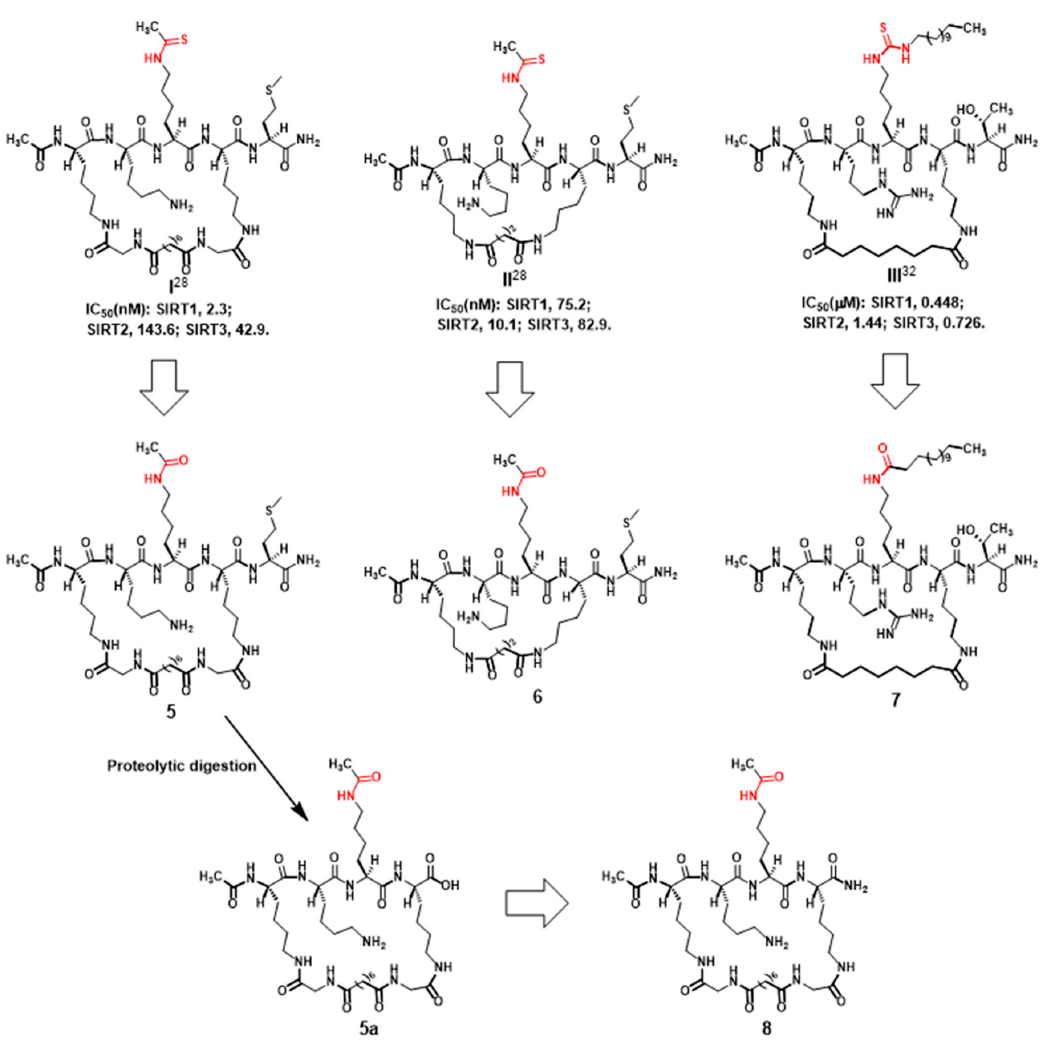
Figure 3. The design of compounds 5 – 8 .